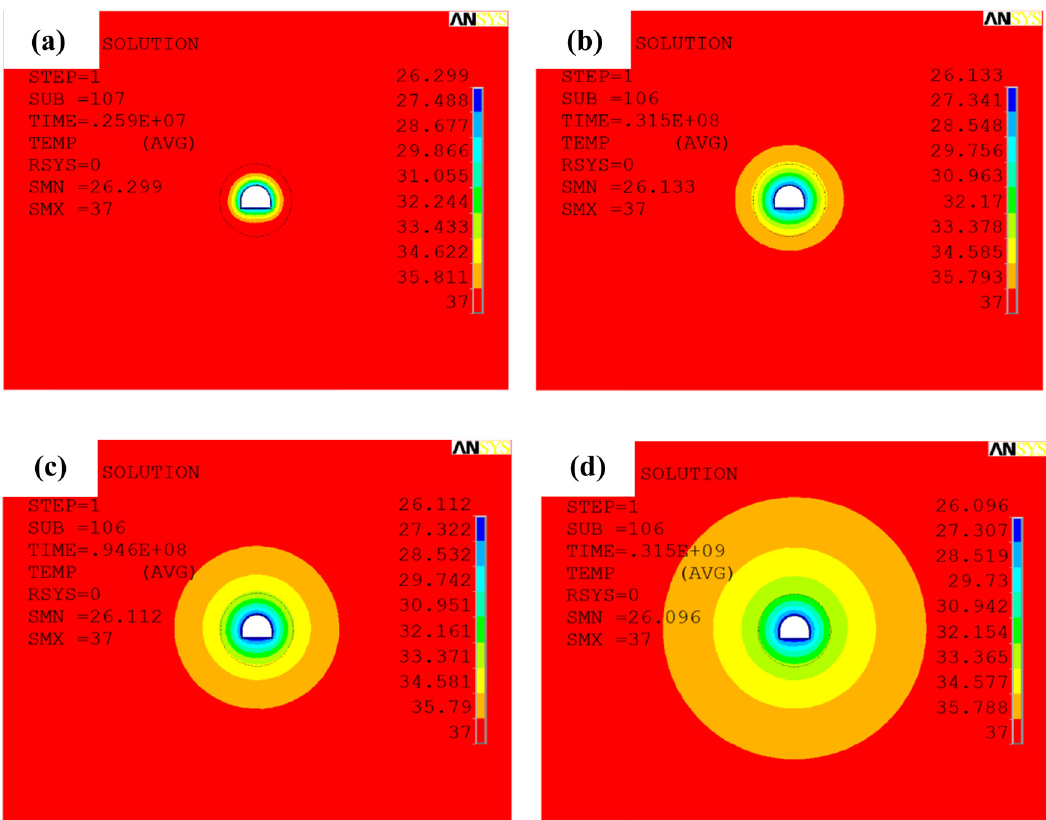
Figure 6: Temperature field of roadway surrounding rock under thermal working condition: ( a ) 30 days; ( b ) 365 days; ( c ) 1,095 days; ( d ) 3,650 days.